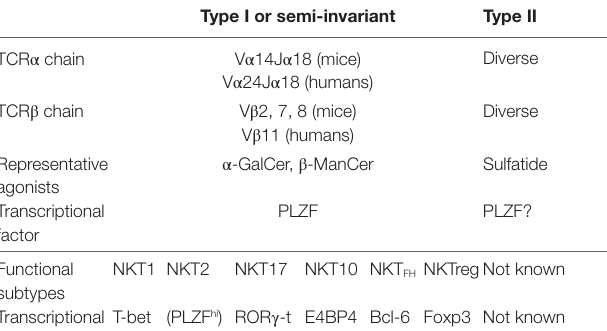
Table 1 | NKT cell